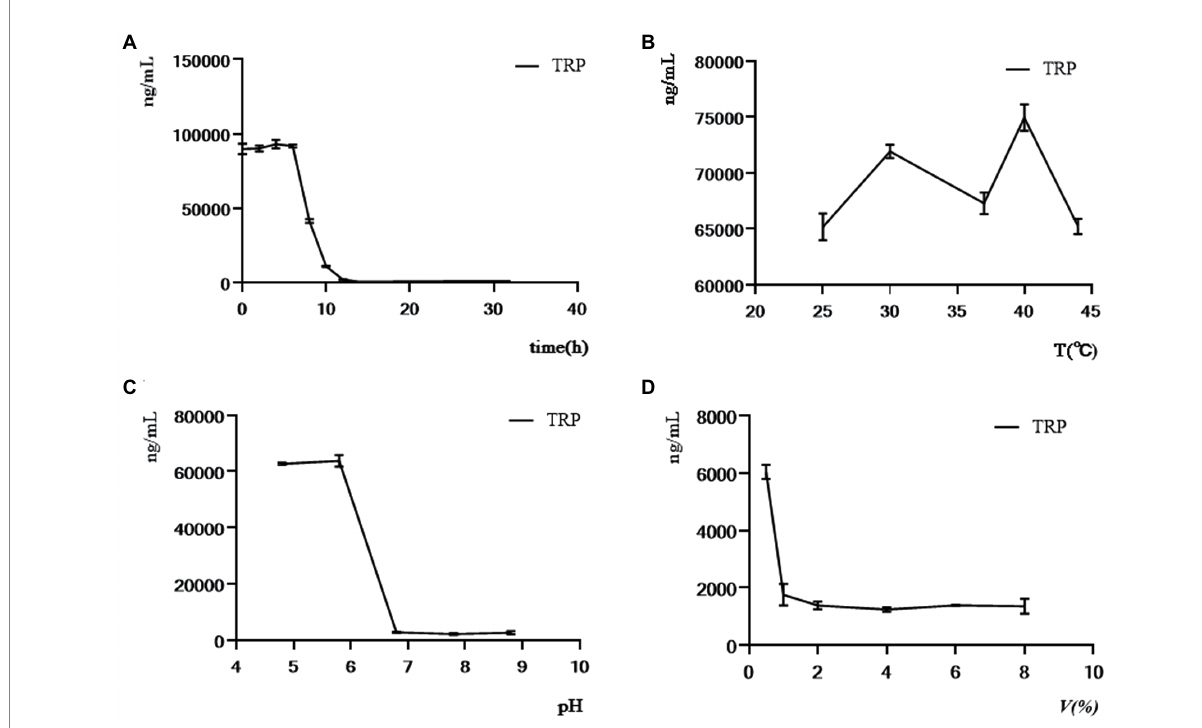
FIGURE 5 Effects of culture time, culture temperature, initial pH of the medium, and inoculum amount on the level of TRP in single-factor experiment. (A) The concentration of TRP was determined in 32 h while maintaining the culture temperature (37 ° C), initial pH of culture medium (6.8), and inoculum quantity (4%) constant. (B) The concentration of TRP at the 20th hour was determined while the initial pH of the medium (6.8) and inoculation amount (4%) remained constant in different temperatures (25, 30, 37, 40, and 44 ° C). (C) The concentration of TRP at the 20th hour was determined while the temperature (37 ° C) and inoculation amount (4%) remained constant in different initial pH of the medium (4.8, 5.8, 6.8, 7.8, and 8.8). (D) The concentration of TRP at the 20th hour was determined while the temperature (37 ° C) and initial pH of the medium (6.8) remained constant in different inoculation amounts (0.5, 1, 2, 4, 6, and